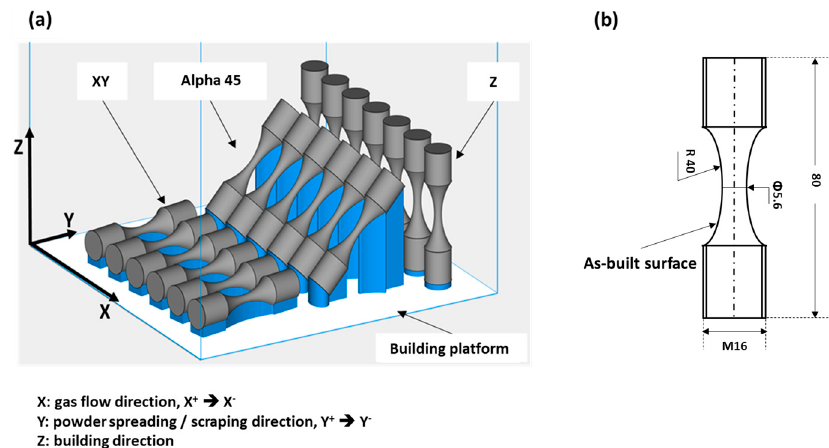
Figure 1. ( a ) Position and orientation of fatigue samples on the building platform showing the building supports (in blue), ( b ) fatigue test specimen. Units in mm.